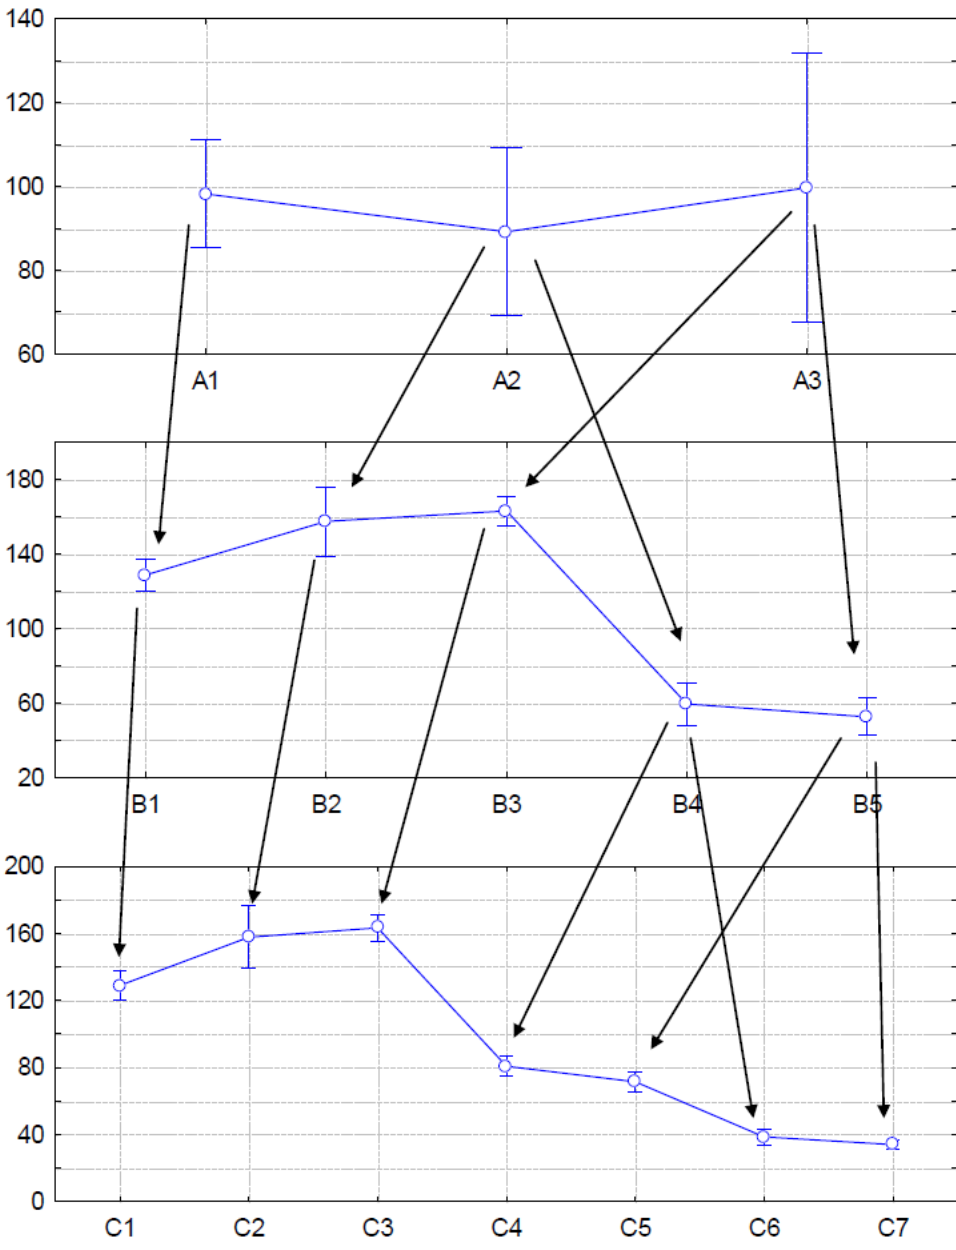
Рис. 1. Иерархическая модель оценки влияния способов обработки почвы на численность (экз. / 10 м 2 ) сорняков (2012–2014 гг.). А1, В1, С1 – контроль; А2, В2, С2 – одноразовая вспашка; А3, В3, С3 – одноразовое дискование; В4, С4